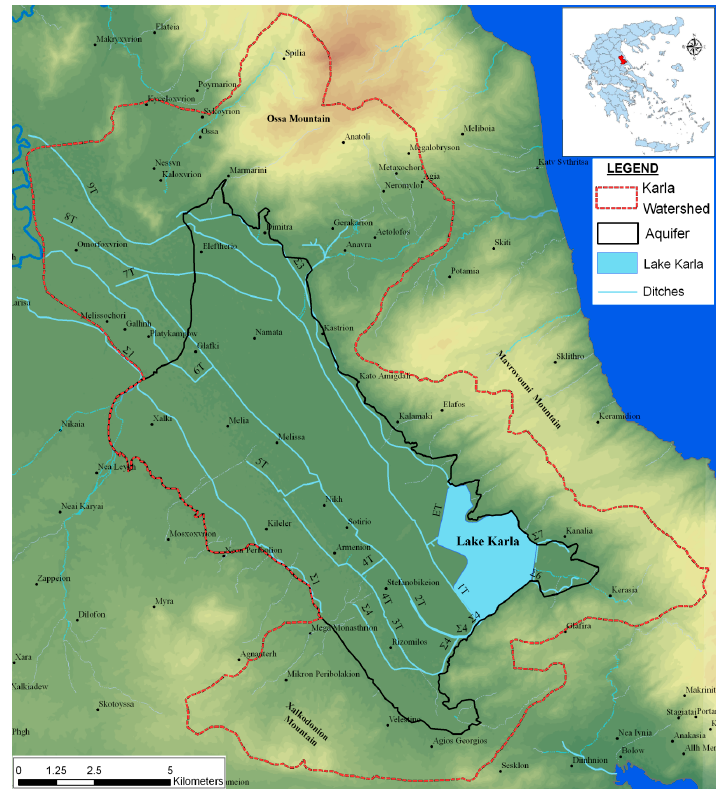
Figure 1. Map of the study area indicating the